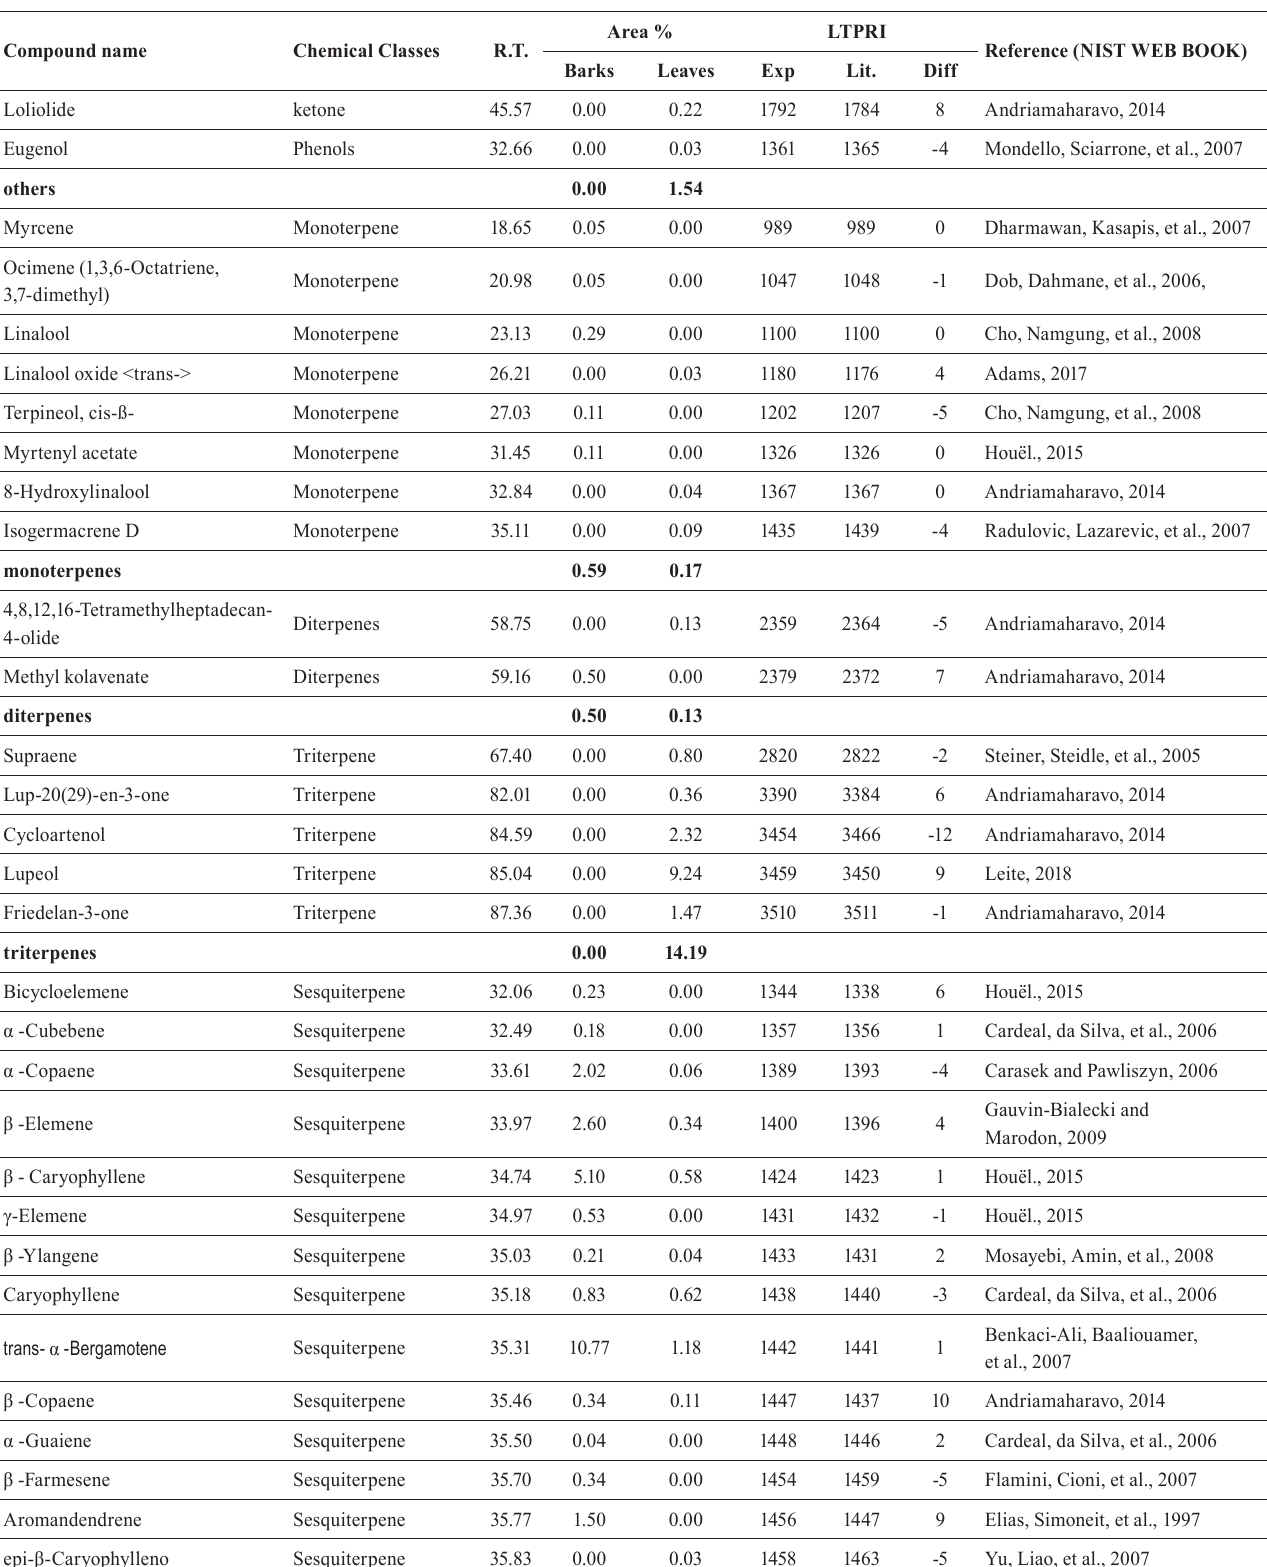
TABLE SI - Tentatively identified compounds in Essential Oils from barks and leaves of Commiphora Leptophloeos by